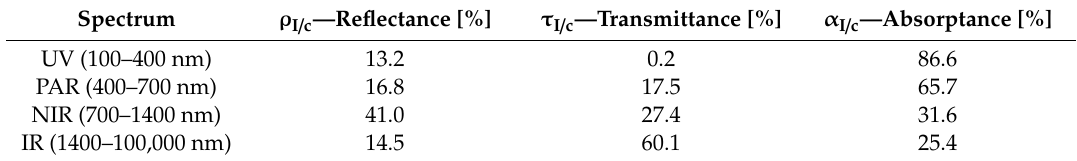
Table 4. Optical properties for the combination of structure I / polyethylene (PE) cover.